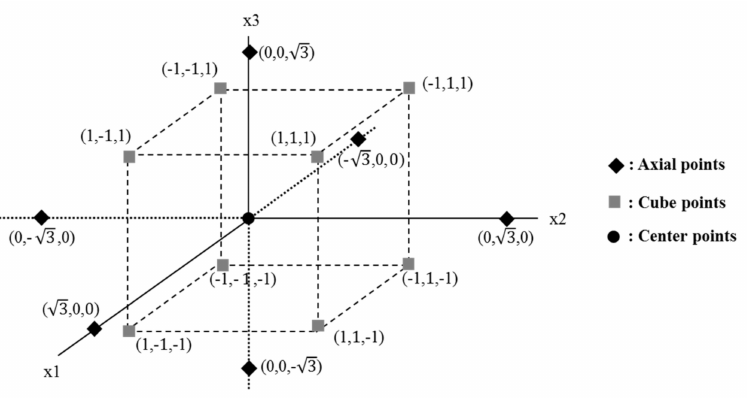
Figure 10. Example points of a central composite design with three input parameters.